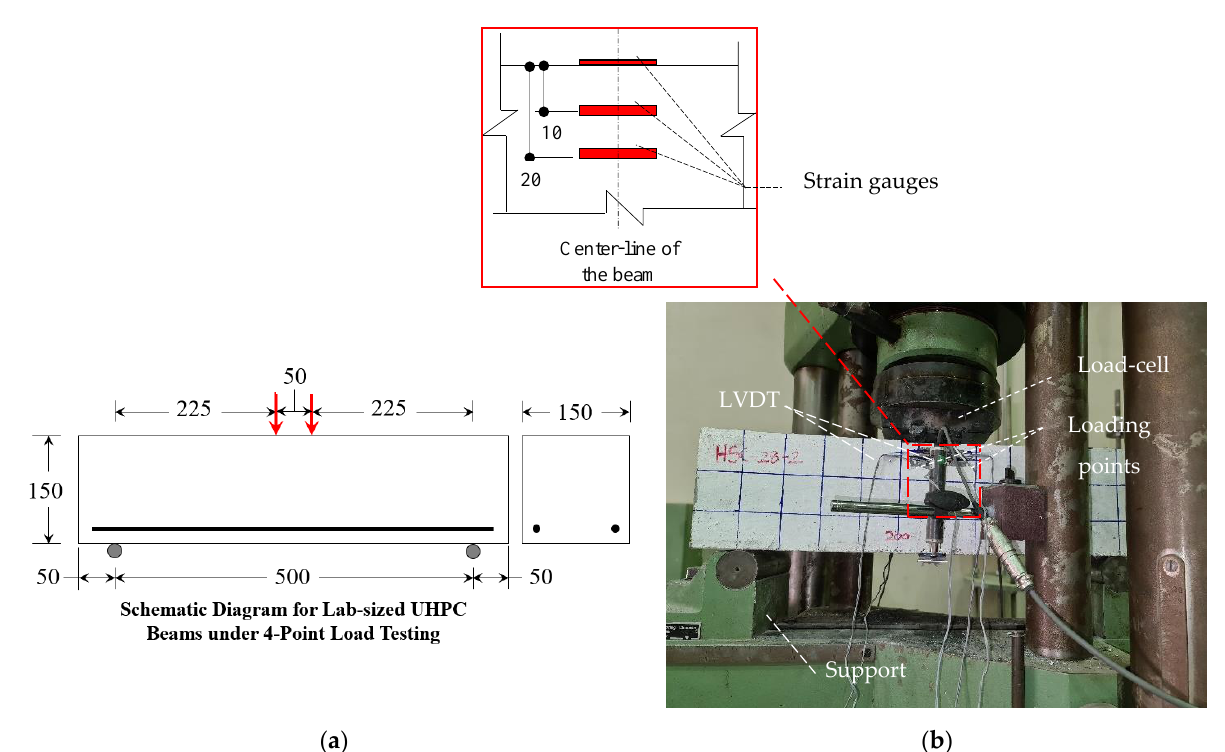
Figure 4. Testing of beams under four-point loading: ( a ) schematic diagram and ( b ) setup and instrumentations (dimensions are in mm).